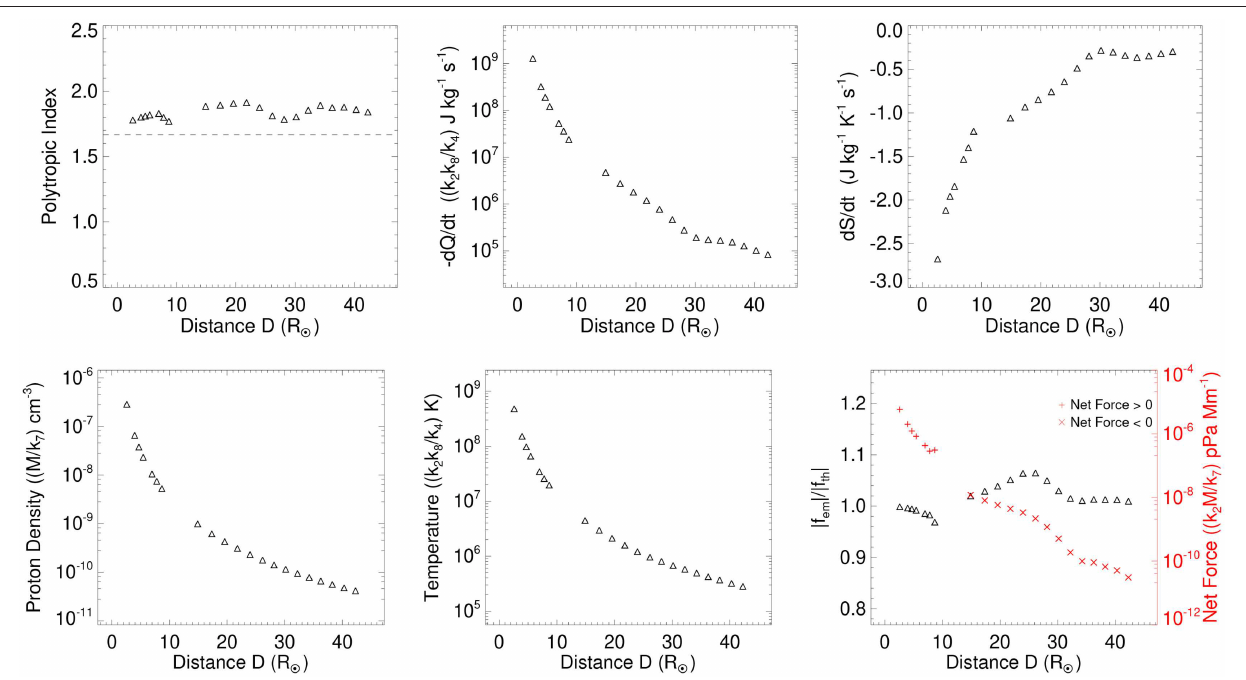
FIGURE 6 | Top : The variation of the polytropic index ( Ŵ ), cooling rate (- dQ / dt ), and rate of change of entropy ( ds / dt ) of the CME with the heliocentric distance of the CME’s center ( D ) are shown in the left, central, and right panels, respectively. Bottom : The average proton number density ( n p ) and Temperature ( T ) of the CME, and different forces acting on the CME with the heliocentric distance of its center ( D ) is shown in the left, central, and right panel, respectively. The bottom-right panel shows the ratio of absolute values of Lorentz and thermal force ( | f em | / | f th | ) (on left Y-axis) and the net force (on right Y-axis) acting inside the